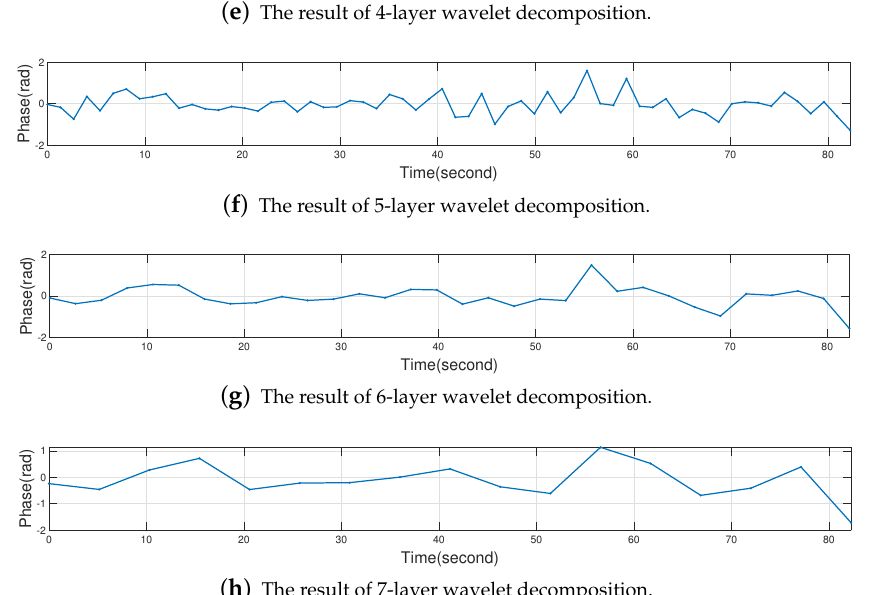
( e ) The result of 4-layer wavelet decomposition.